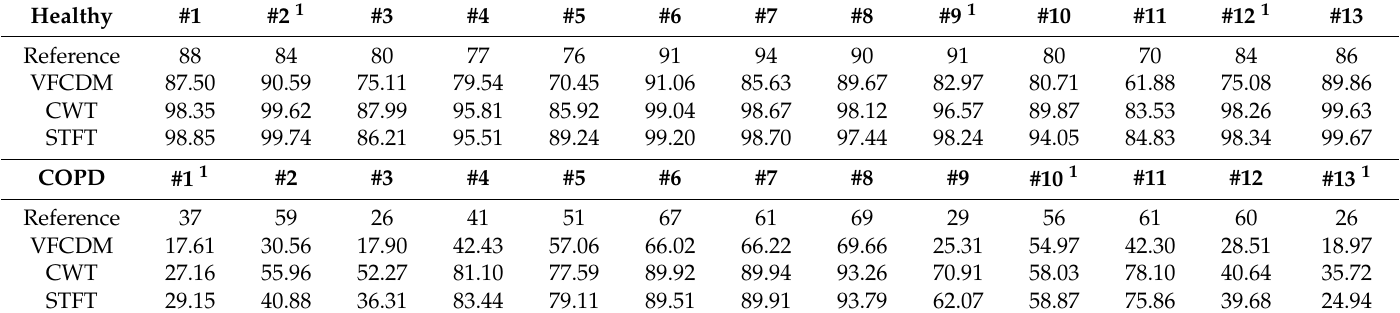
Table 5. Individual estimation values of FEV1/FVC at TH P = 100% using VFCDM, CWT, and STFT methods. Table 5 summarizes the whole estimated FEV 1 /FVC ratios from each subject at TH P = 100% for